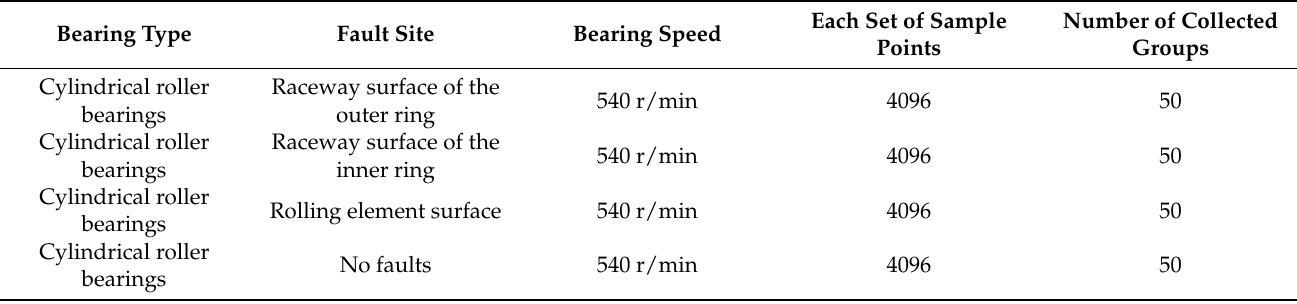
Figure 12. Acceleration signal acquisition system. The parameter settings of this experiment are shown in Table 4. Table 4. Explanation of experimental